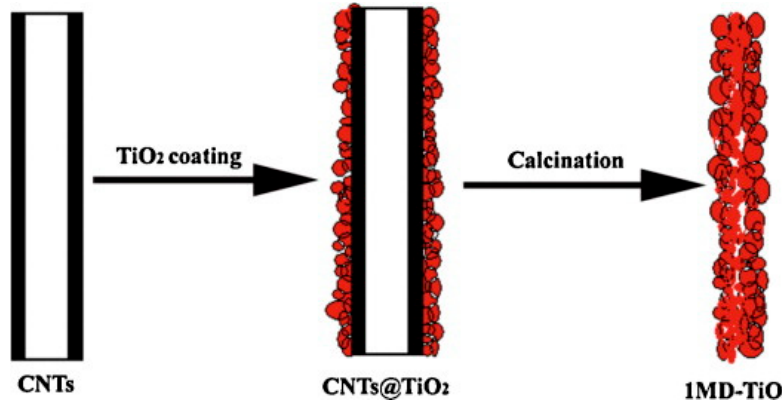
Figure 8. The fabrication process of 1DM-TiO 2 . Reprinted with permission from reference [40]. Copyright 2018, Elsevier.